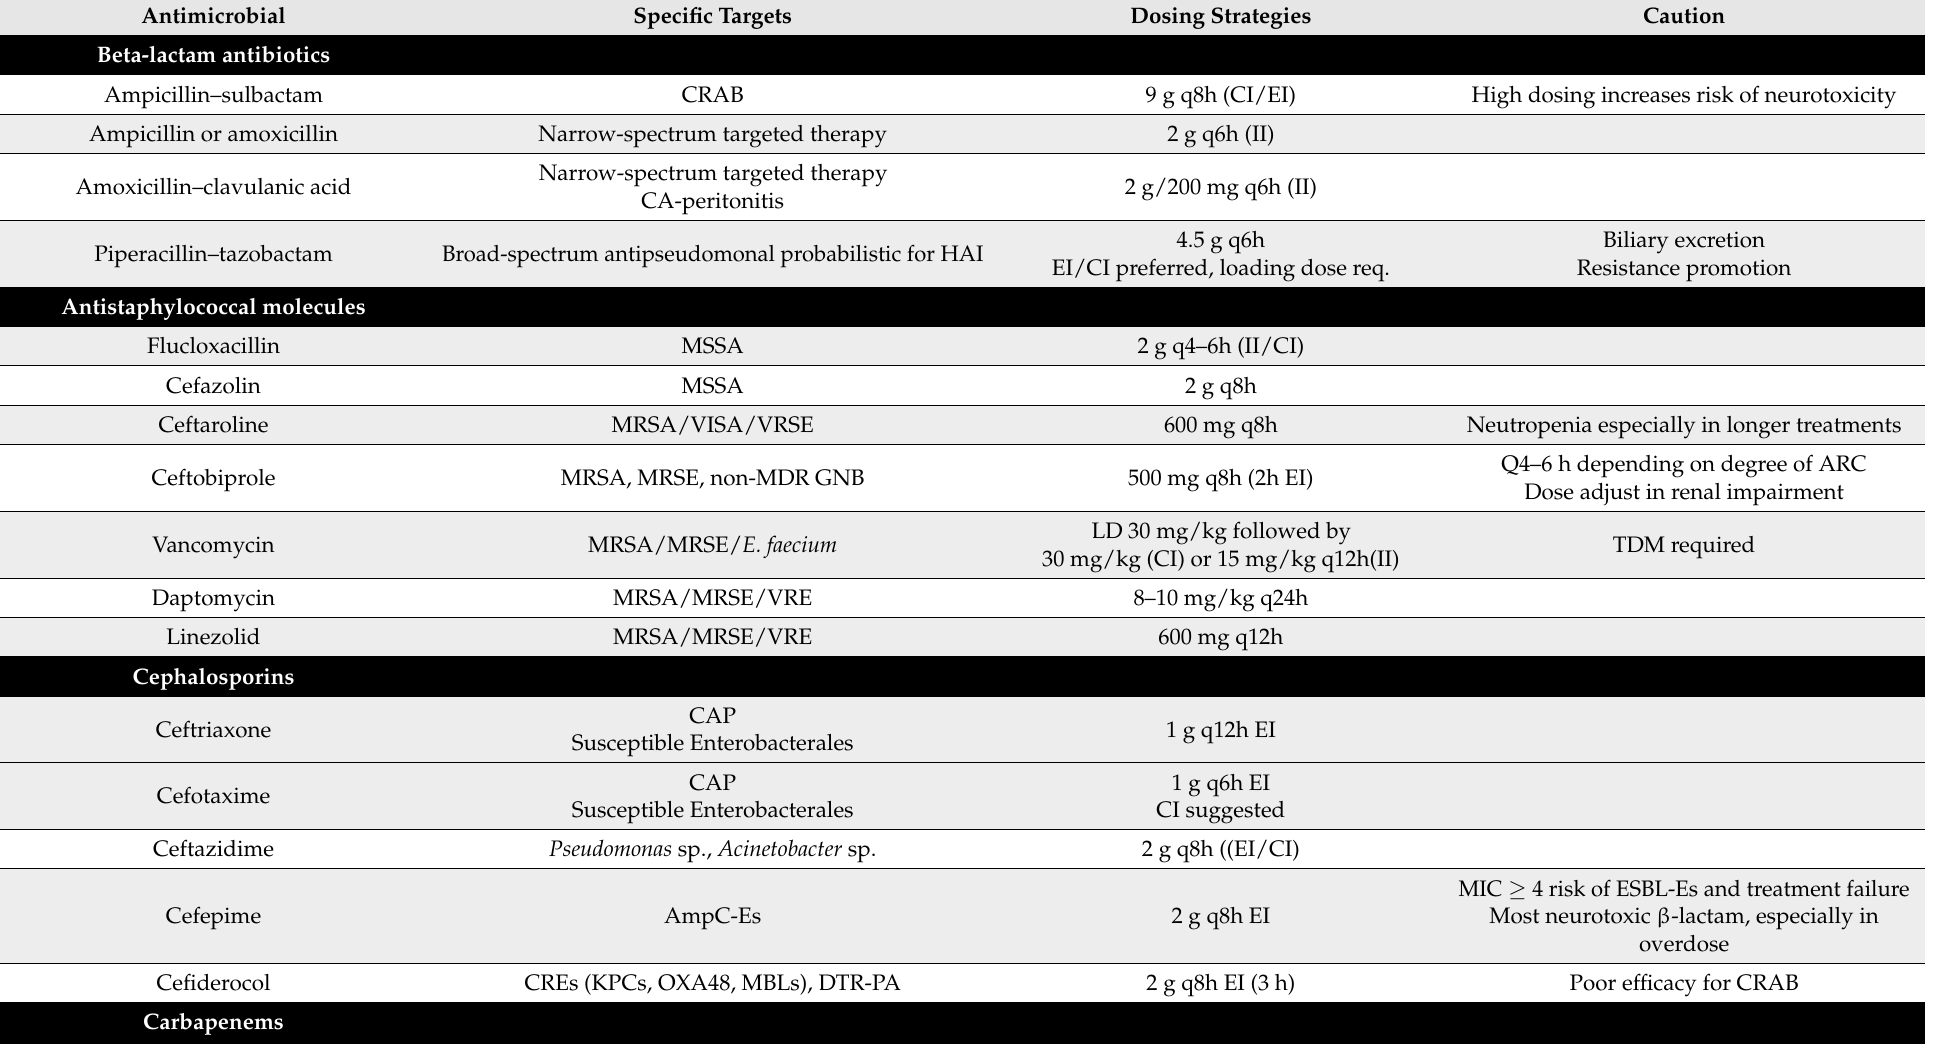
Table 3. Targets and dosing strategies for most commonly used